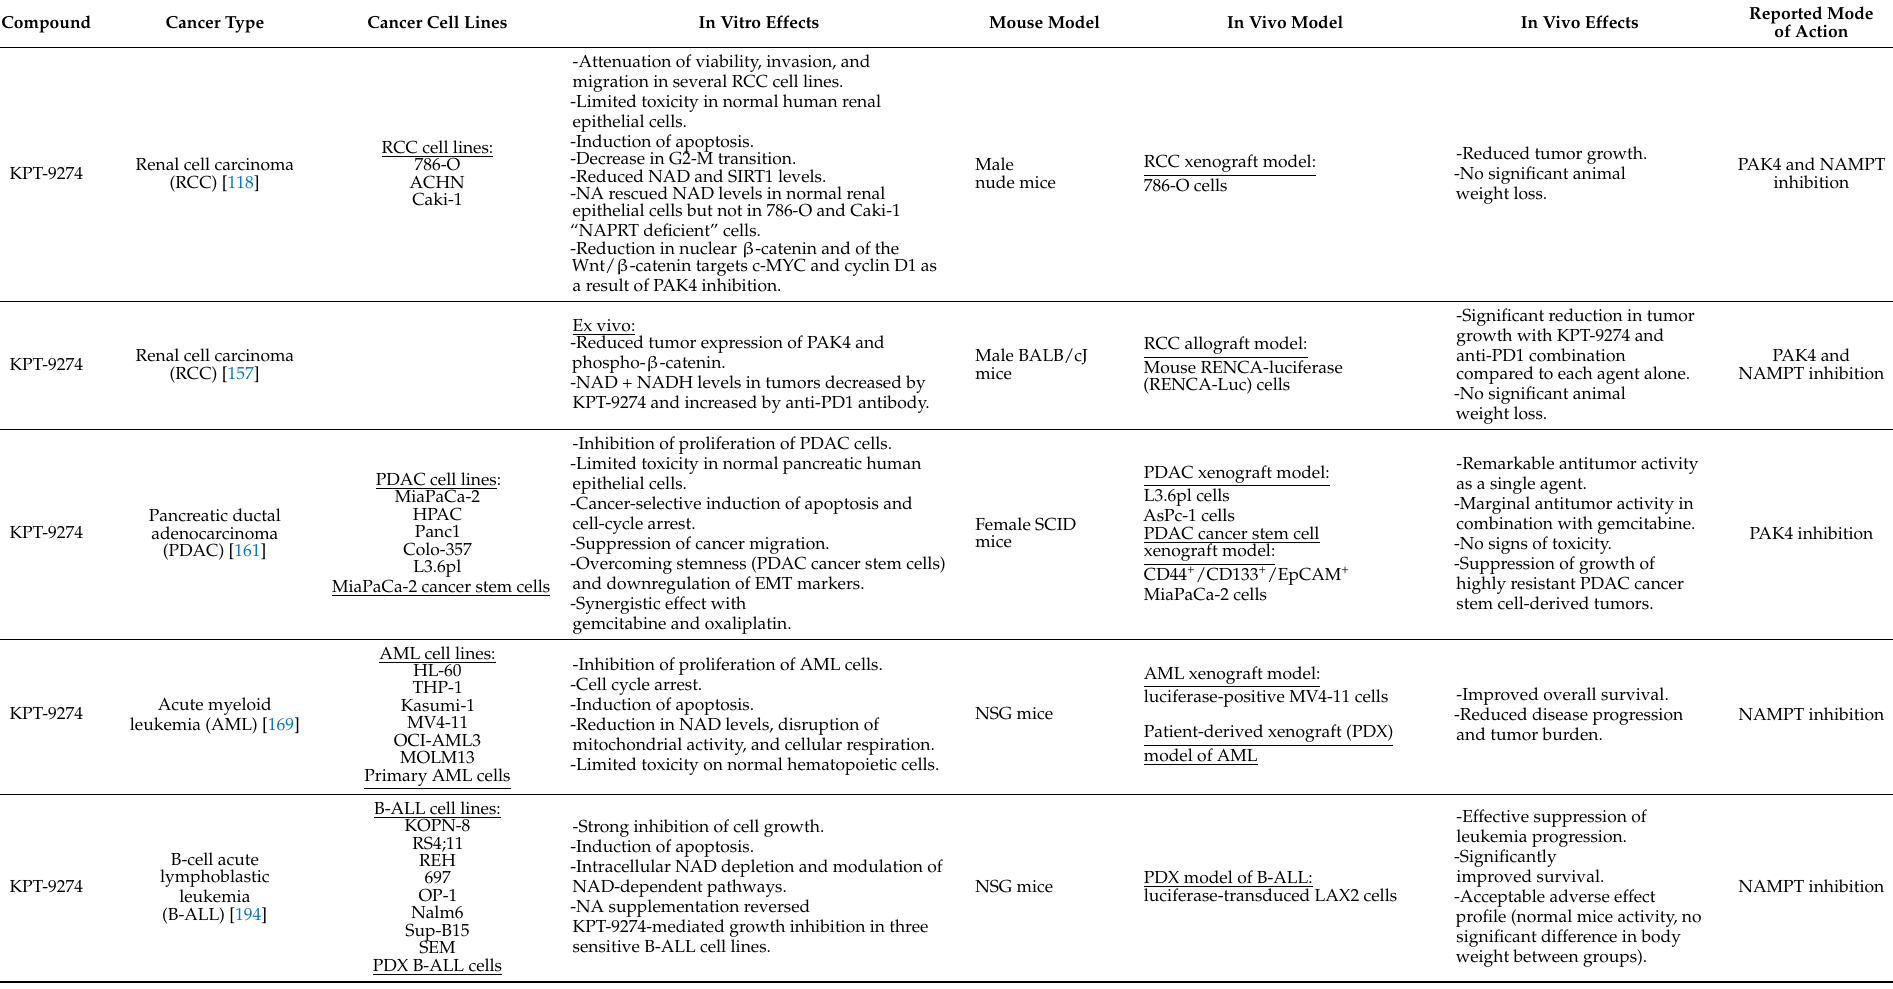
Table 3. Summary of the reported preclinical studies of the NAMPT inhibitors that are currently being evaluated in clinical